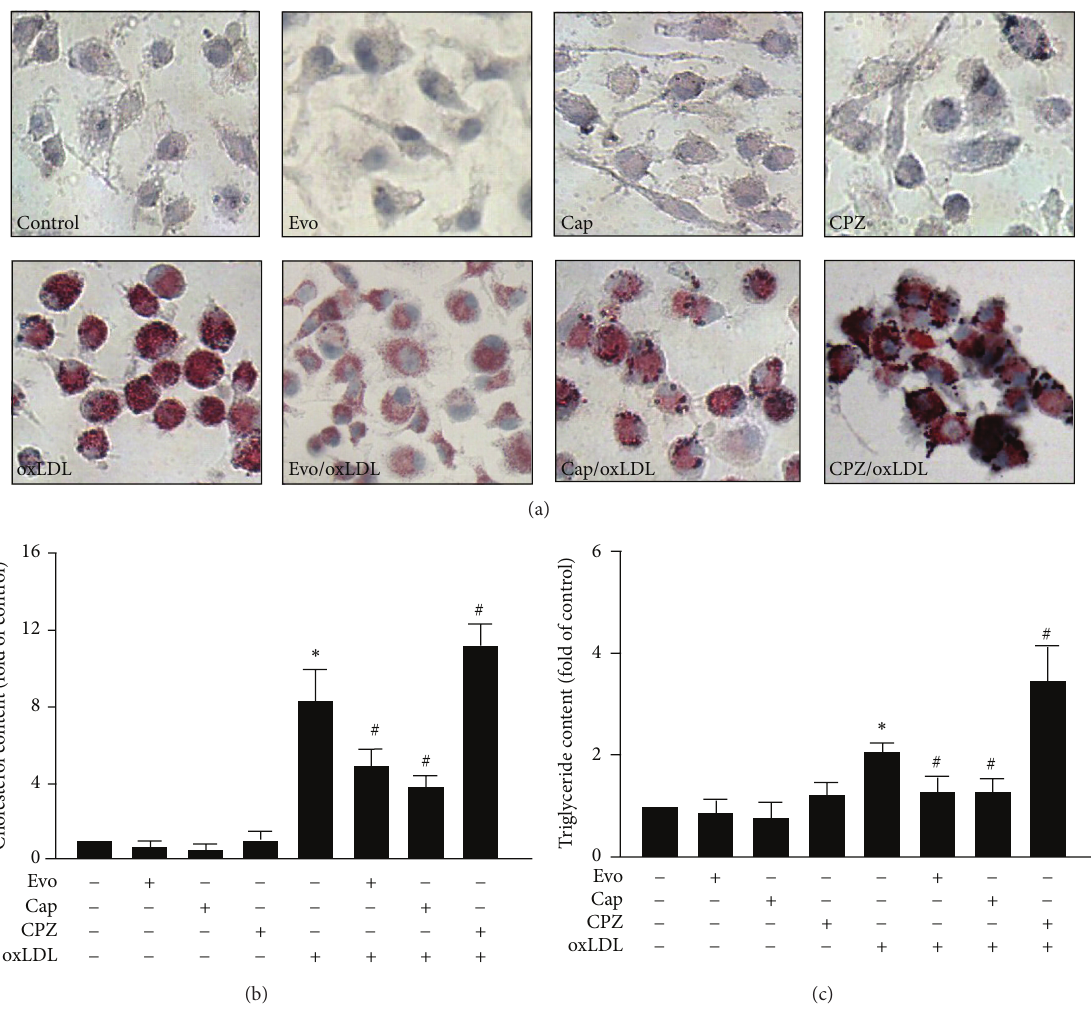
Figure 3: Activation of TRPV1 by agonists alleviates oxLDL-induced foam-cell formation.Cells were incubated with vehicle (DMSO), evodiamine (0.5 𝜇 M), capsaicin (10 𝜇 M), or capsazepine (10 𝜇 M) with or without oxLDL (50 𝜇 g/mL). (a) Representative microscopy images of cellswithintracellularlipidsstainedbyOil-redO.Hematoxylinwasusedascounterstaining.Magnification = 400 x.((b)and(c))Intracellular levels of cholesterol (b) and triglycerides (c) were extracted by use of hexane/isopropanol (3/2, v/v) and analyzed by colorimetric assay kits. Data are mean ± SD from 5 independent experiments. ∗ 𝑃 < 0.05 versus vehicle-treated cells, # 𝑃 < 0.05 versus oxLDL-treated